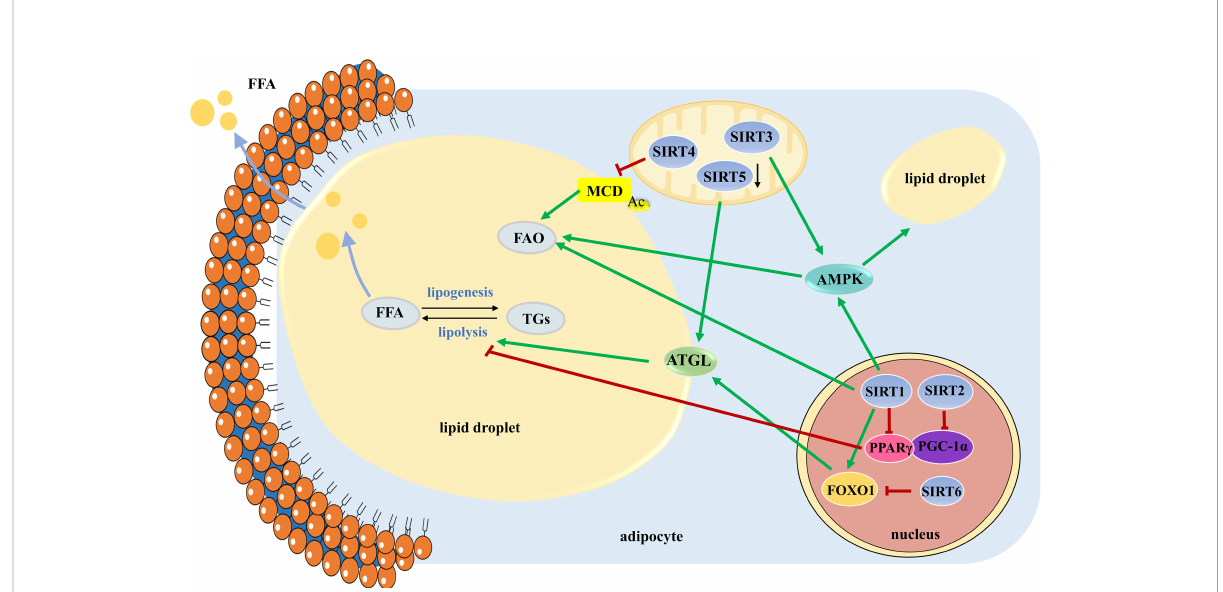
FIGURE 2 The roles of SIRT1-SIRT6 in manipulating lipid mobilization. Lipid mobilization is comprised of lipogenesis and lipolysis. Large lipid droplets are separated into small ones to initial lipolysis. TGs stored in lipid droplets are mobilized by the hydrolytic action of the three main lipases of the adipocyte to release FFAs, which are broken down to produce energy through FAO. TGs, triglycerides; FFAs, free fatty acids; FAO, fatty acid